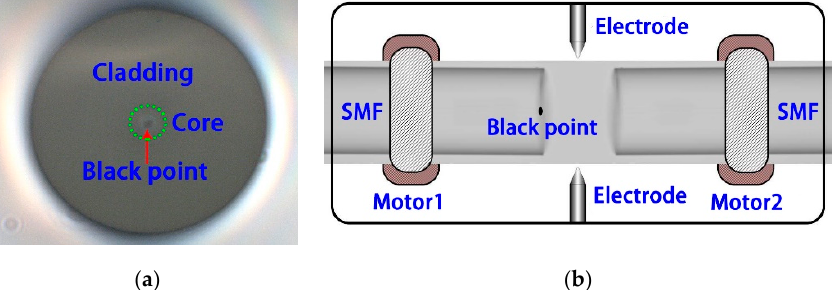
Figure 1. ( a ) Fiber end face ablated by femtosecond laser; ( b ) ablated single mode fibers (SMF) being spliced with the other normal SMF.